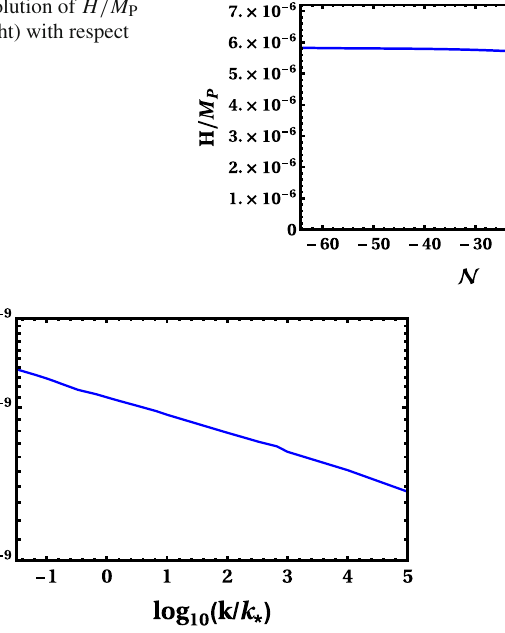
Fig. 5 The square roots of the eigenvalues of M I for three heavy modes for four BPs during the inflation normalized by the Hubble parameter